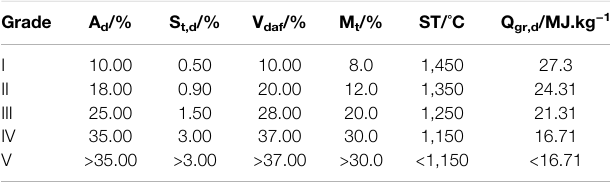
TABLE 2 | Standard limits of basic items for thermal coal classi fi cation quality standards.